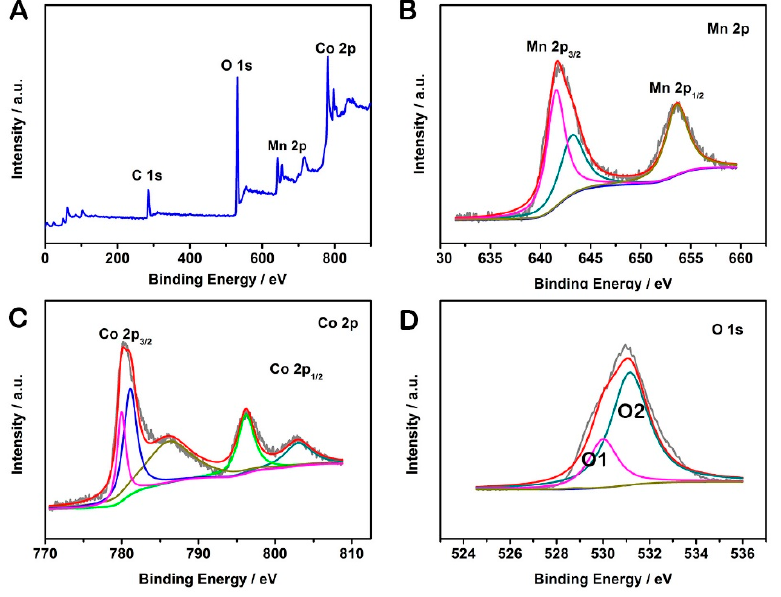
Figure 3. ( A ) X-ray photoelectron spectroscopy (XPS) survey spectrum, ( B ) high-resolution XPS spectrum of Mn 2p. ( C ) Co 2p and ( D ) O 1s for the MnCo-G sample.